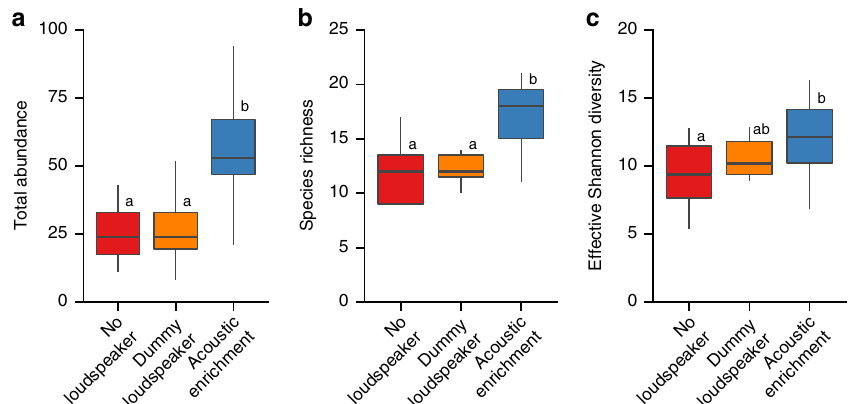
Fig. 3 Community-level effects of acoustic enrichment. a Total abundance, b species richness, and c effective Shannon diversity of juvenile fi sh communities on experimental patch reefs. Boxplots represent medians (central lines), interquartile ranges (boxes) and 95% ranges (whiskers). Linear mixed models revealed signi fi cant effects of loudspeaker treatment in all three cases; different letters above boxplots represent signi fi cant differences in post-hoc Tukey ’ s HSD tests (Supplementary Table 1). Absolute values for species richness and Shannon diversity are likely to be underestimates, as fi sh that were only identi fi ed to higher taxonomic levels (family or subfamily) may represent more than a single species.